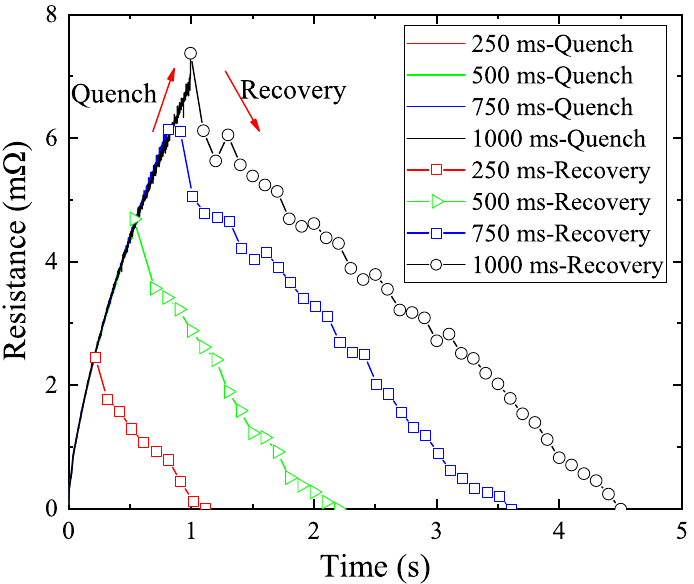
Figure 4. Resistance of the sample during the quench and recovery processes at pulse durations of